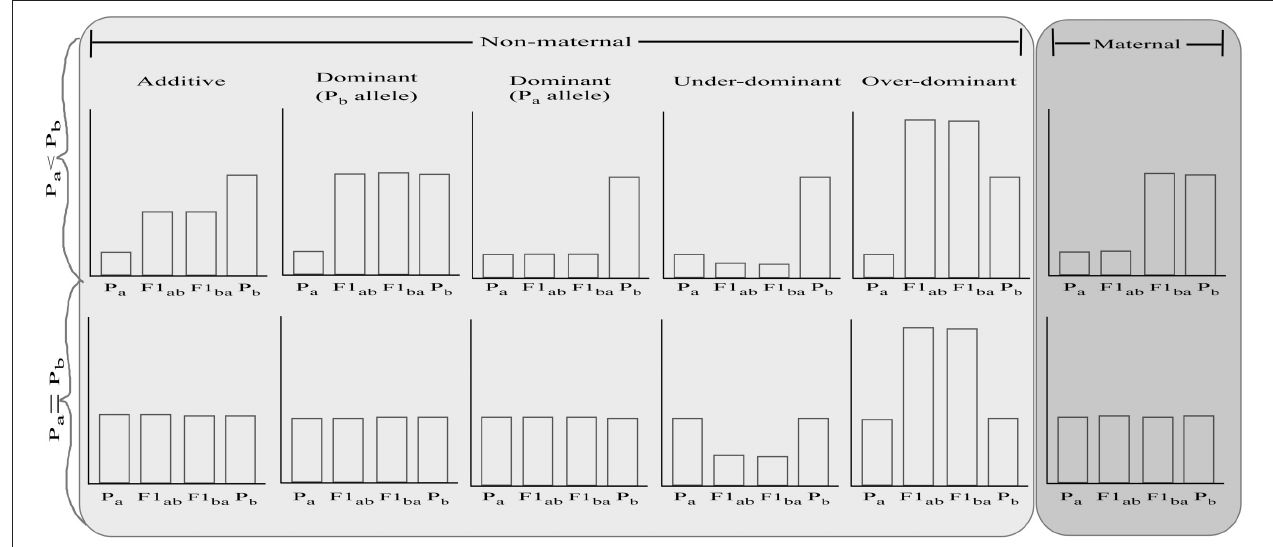
FIGURE 1 | Possible relative fitness of reciprocal F1 hybrids (F1 ab and F1 ba ) based on fitness of the parental species (P a and P b ) and the driving mechanism. In the top graphs, parental species are assumed to differ in phenotype while the bottom graphs indicate a situation where parental species are similar. For further explanation, see